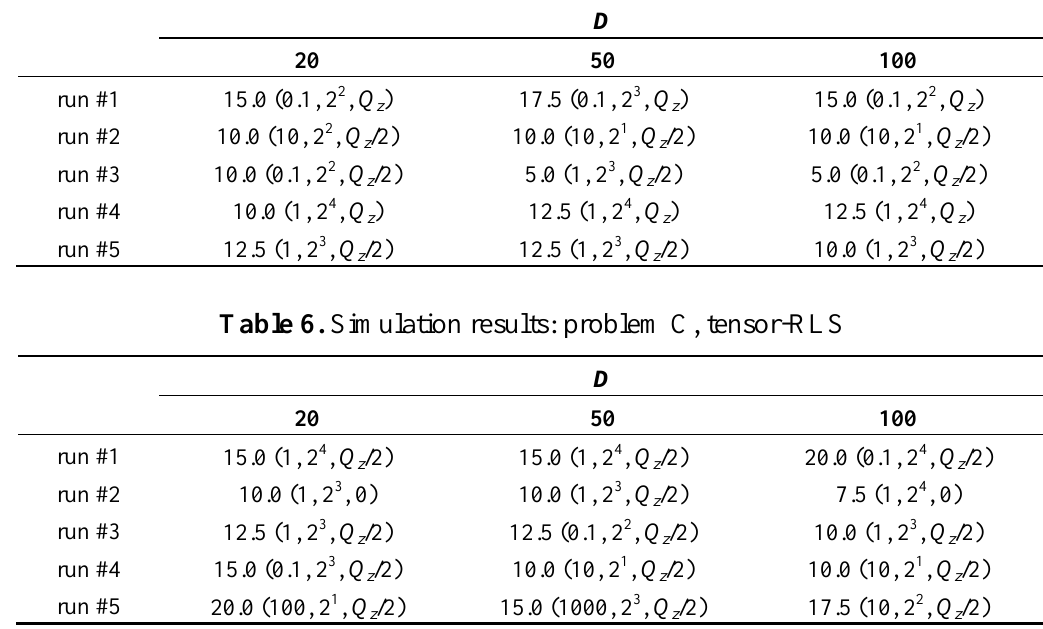
Table 5. Simulation results: problem B, tensor-RLS.